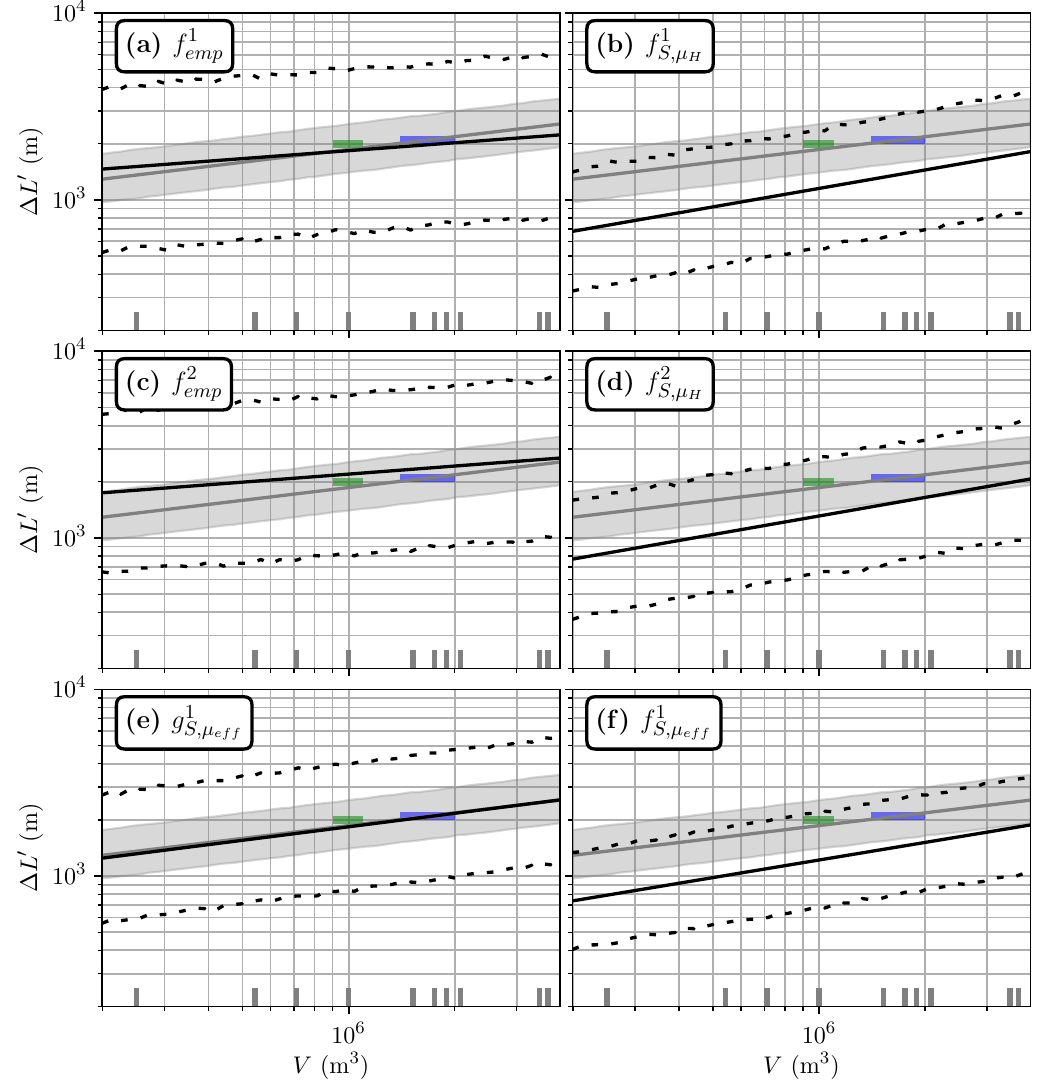
Figure 7. Travel distance estimated from volume for the Samperre case study. Green and blue rectangles: estimations of volumes and travel distances for the 2009 and 2018 collapses, respectively. Grey line: Numerical estimation from back-analysis ( f fit ), with µ S = tan ( 13.5 ◦ ) = 0.24. The grey area is the upper S = tan ( 13 ◦ = tan ( 13.5 ◦ and lower limits of the 95% prediction intervals derived for µ fit 2 ◦ ) µ fit 2 ◦ ) . S S ± ± ( a ) Estimation with f 1 emp . ( b ) Estimation with f 1 . ( c ) Estimation with f 2 emp . ( d ) Estimation with f 2 . S , µ H S , µ H ( e ) Estimation with g 1 . ( f ) Estimation with f 1 . Black lines are direct estimates, dashed lines give S , µ eff S , µ eff the 95% prediction